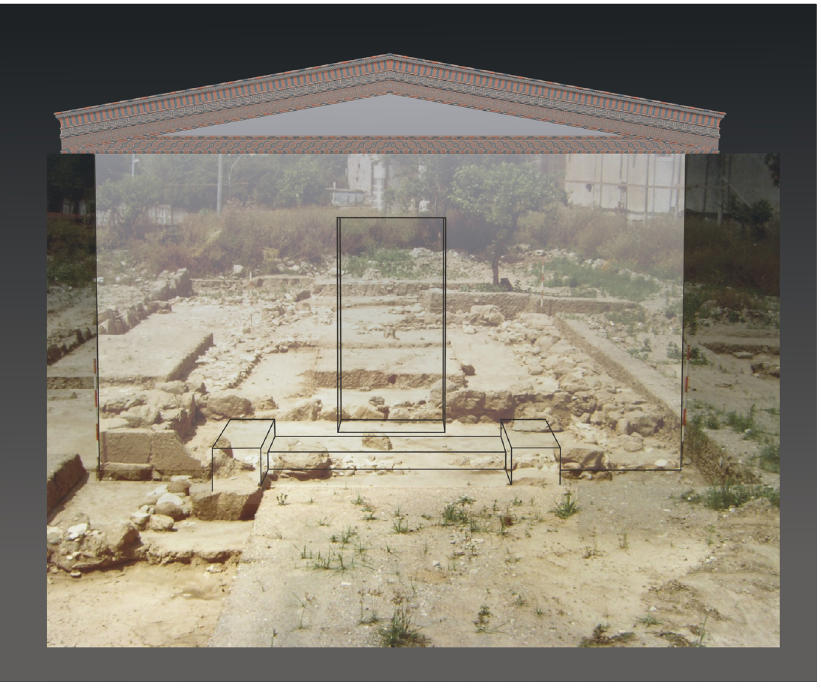
Figure 6. Tempietto H. Perspective view of the reconstruction fitted on top of an excavation photograph of the site (Jari